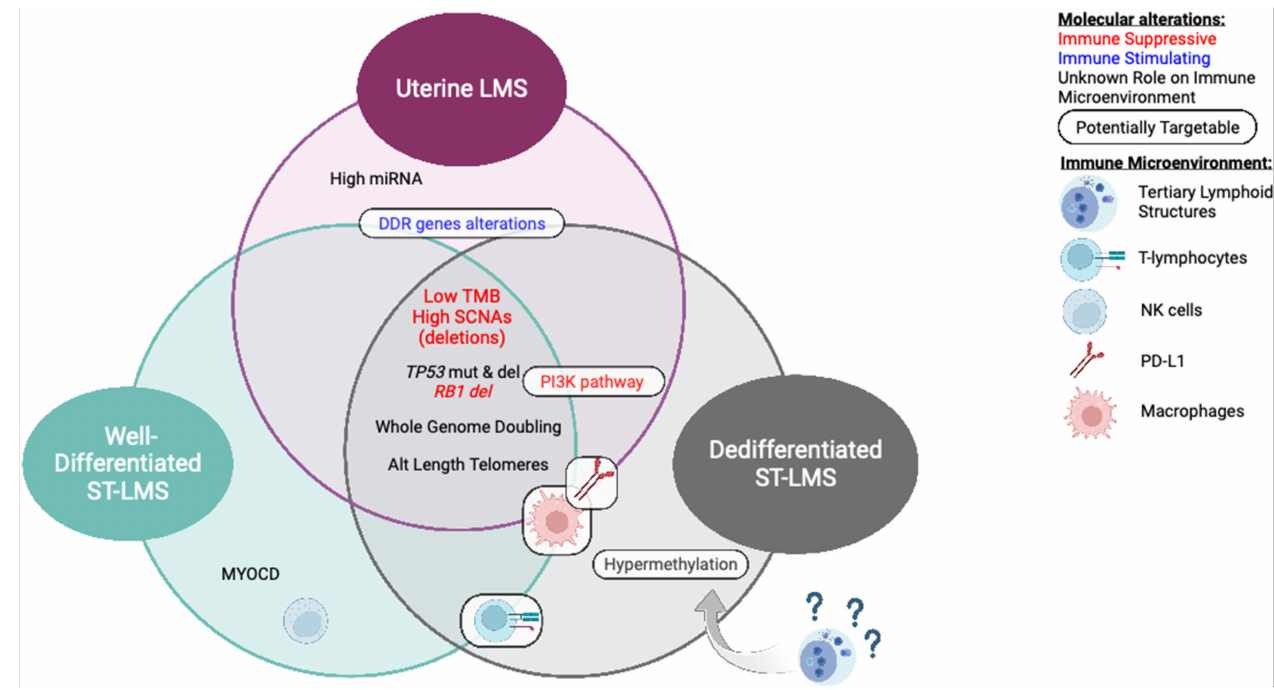
Figure 2. Molecular alterations and immune microenvironment associated with molecular subtypes of